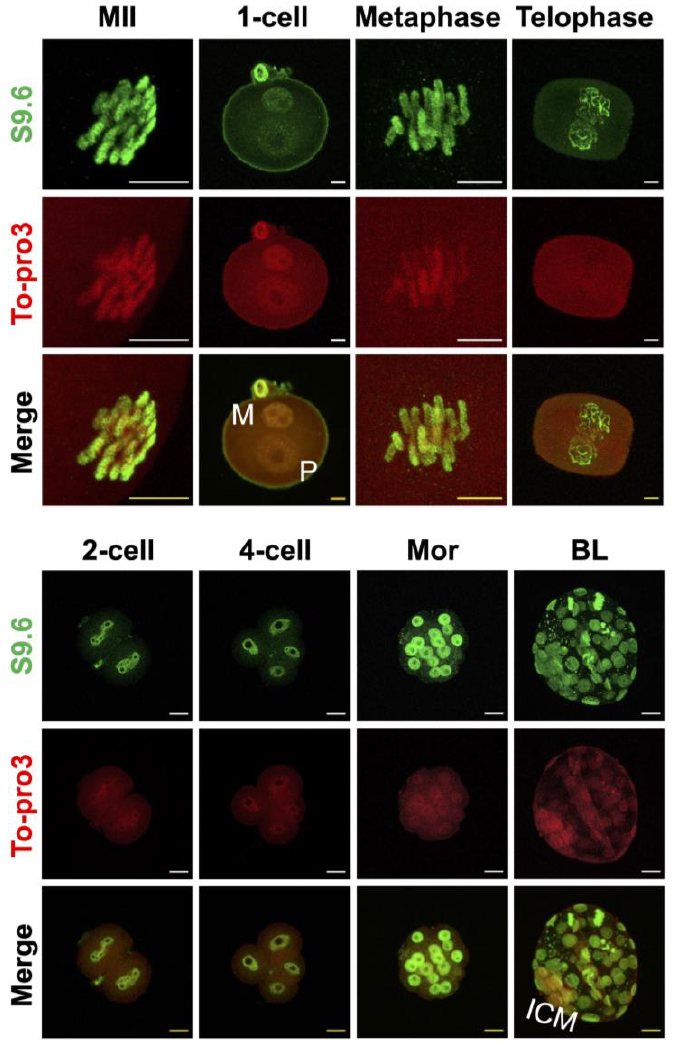
Figure 2. R-loops persist through the pre – implantation stage embryo. Representative images of the maximum intensity z-stack projection of each preimplantation stage embryo. Immunofluorescence detection of the R-loop (S9.6 antibodies, green), DNA (To-pro3, red), and merged image of these two channels (merged) in metaphase II stage oocytes (MII), pronucleus stage zygote (1-cell), metaphase stage of the 1-cell zygote (metaphase), telophase stage of the 1-cell zygote (telophase), 2-cell, 4-cell, Mor (morula), and BL (blastocyst). M, paternal pronucleus; P, paternal pronucleus; ICM, inner cell mass. All scale bars = 10 µM.